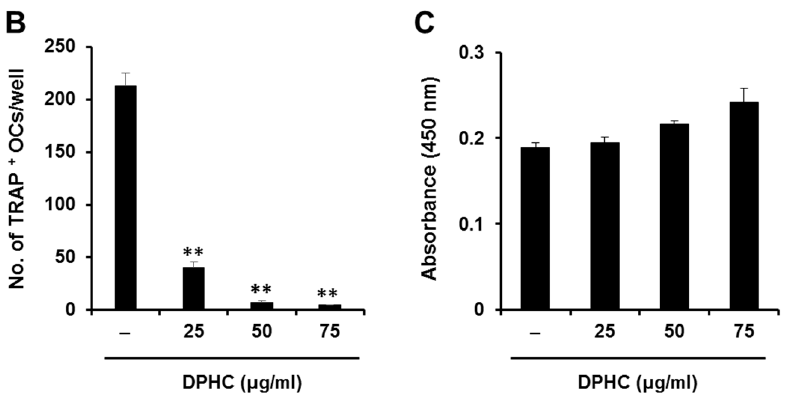
Figure 1. Effects of diphlorethohydroxycarmalol (DPHC) on receptor activator of nuclear factor- κ B ligand (RANKL)-mediated osteoclast differentiation in bone marrow macrophages (BMMs). ( A ) BMMs were cultured for four or five days in osteoclastogenic media containing macrophage-colony stimulating factor (M-CSF) (10 ng/mL) and RANKL (20 ng/mL) with or without various doses of DPHC. The cells were stained for TRAP; ( B ) The number of TRAP-positive multinucleated cells (MNCs) with ≥ 3 nuclei was scored. ** p < 0.01 versus vehicle-treated control; ( C ) BMMs were incubated with the indicated doses of DPHC in the presence of M-CSF (10 ng/mL) for three days. Cell viability was assessed by the cell counting kit-8 (CCK-8). TRAP: tartrate-resistant acid phosphatase; OCs: osteoclasts.